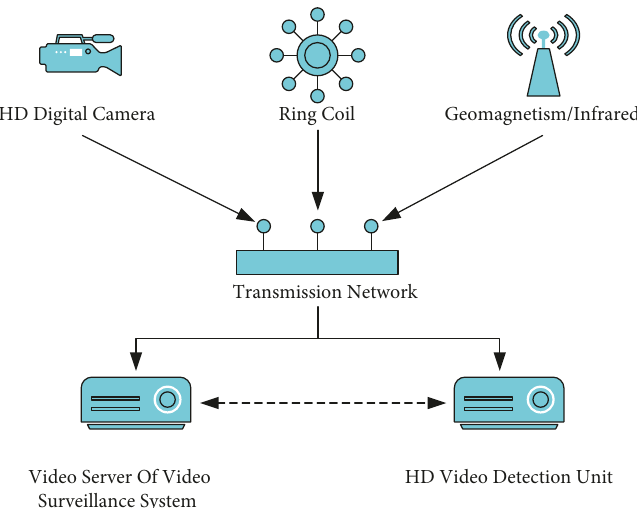
Figure 1: Architecture of traffic congestion detection